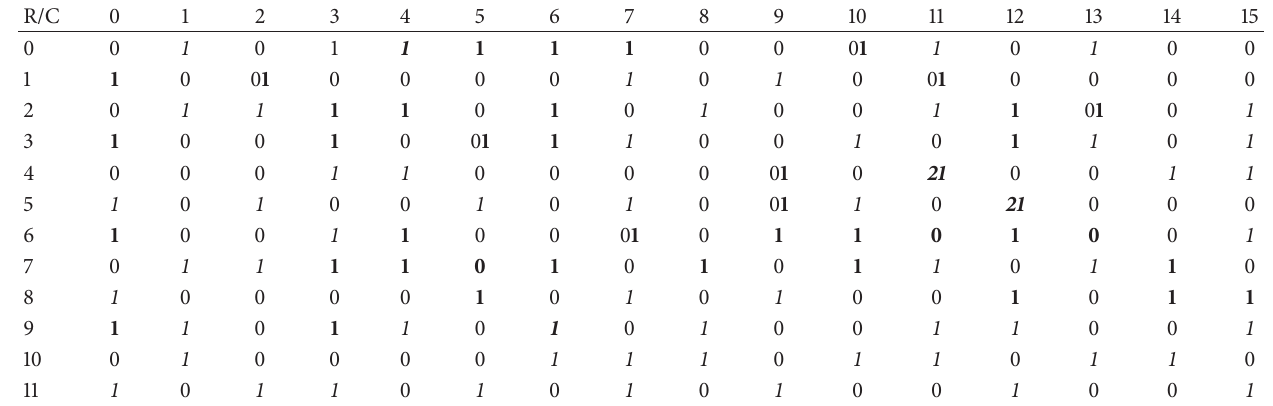
Table 2: The new grid grid[i][j] obtained using the algorithm.